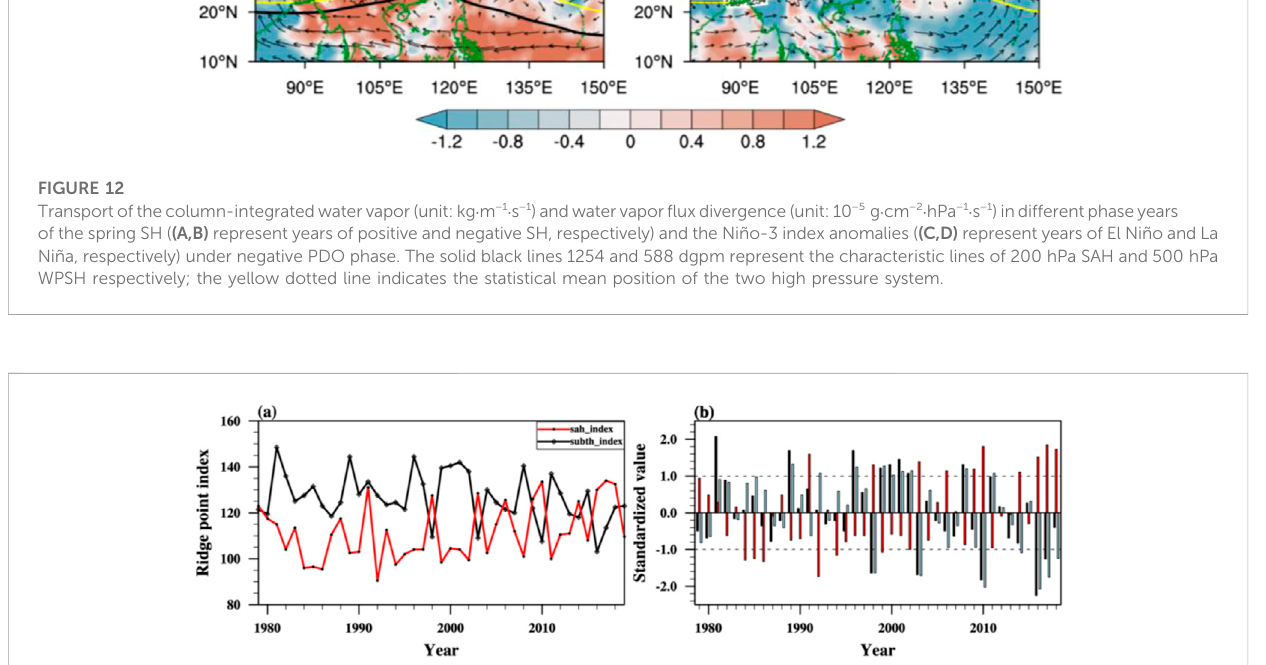
FIGURE 13 (A) Index of the east ridge point of the spring SH over the TP and the west ridge point of the WPSH and the (B) standardized zonal relative position anomaly. The solid red and black lines in (A) denote the index of ridge points of the SH and the WPSH, respectively. The red, black, and blue bars in (B) indicate the standardized anomaly index of the east ridge points of the SAH, the east ridge point of the WPSH, and the relative position change, respectively. The dashed lines denote ±1.0- σ .